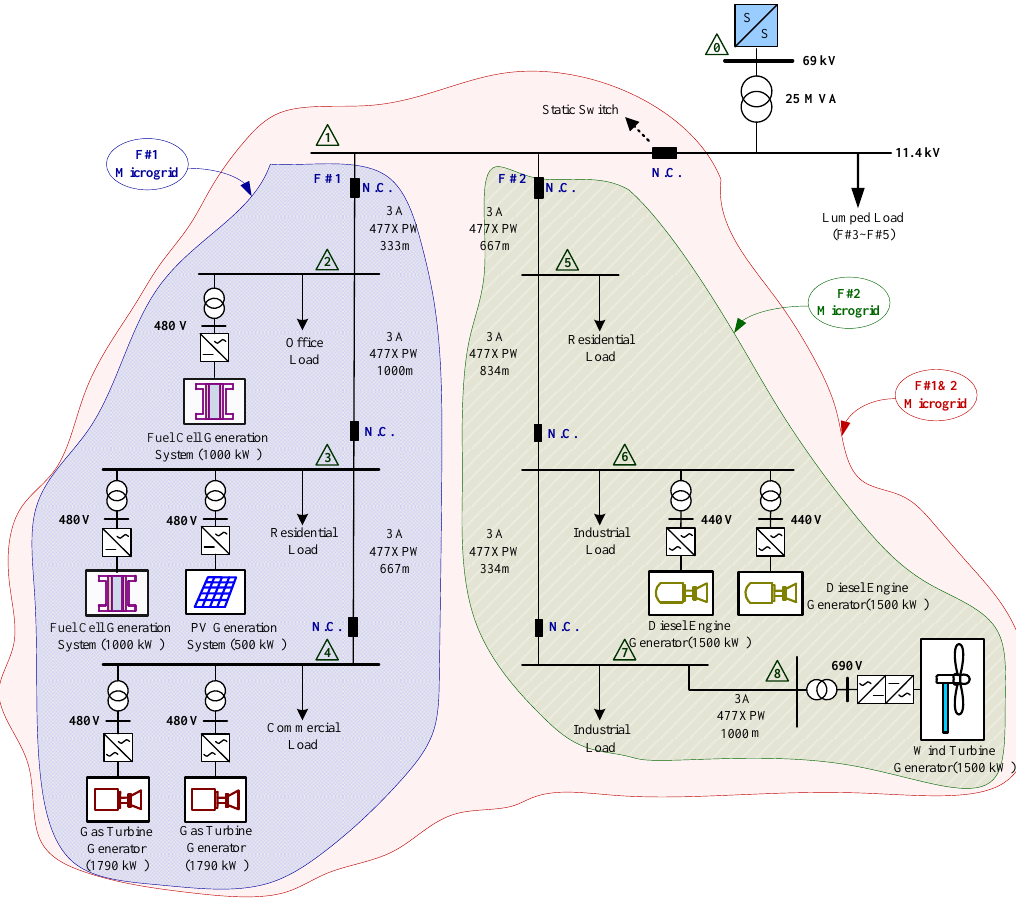
Figure 1. System structure of an 11.4 kV medium-voltage microgrid